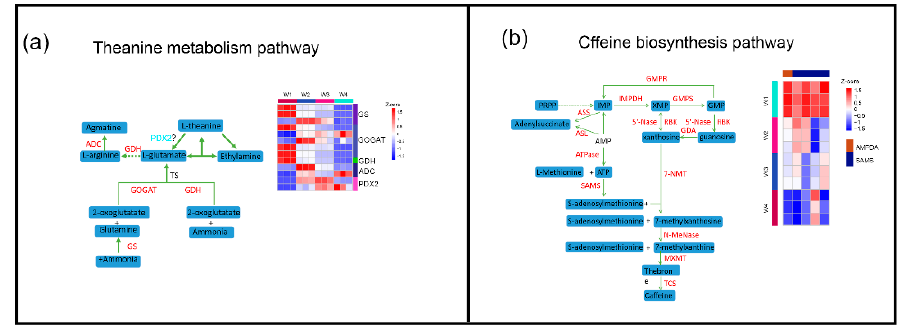
Figure 6. Effect of withering on theanine metabolism and caffeine biosynthesis pathways in tea leaves. A simplified model of theanine metabolism ( a : left) and caffeine biosynthesis pathways ( b : left) in tea plants and a heat map showing the expression pattern ( a , b : right) of related DEGs based on the Z-core value at different timepoints during the withering process. The DEGs were strictly filtrated by |log2 (fold change) | ≥ 2 and p value < 0.05, with at least one of three comparisons (W2 vs. W1, W3 vs. W1 and W4 vs. W1). Blue represents a low expression level, and red represents a high expression level.